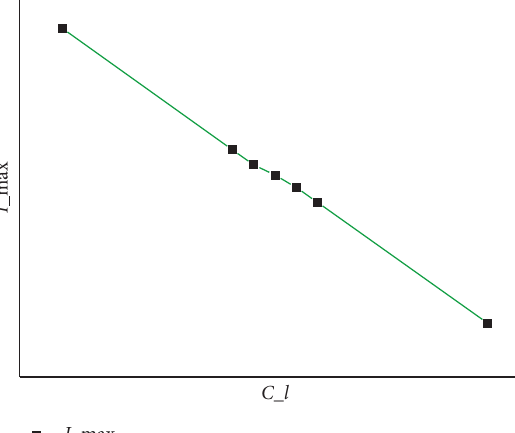
Figure 14: Diagram of overlapping cost-maximum